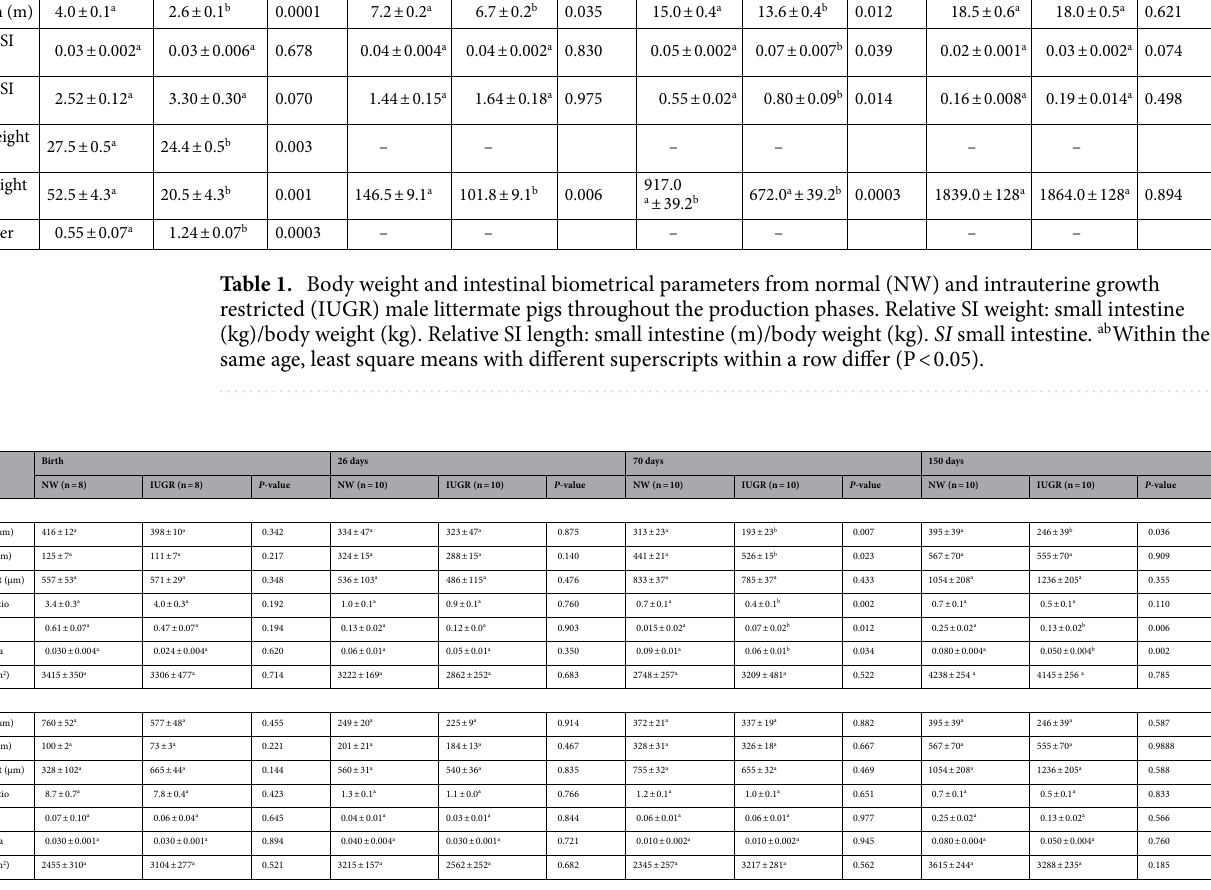
Table 2. Small intestine histomorphometrical parameters from normal (NW) and intrauterine growth restricted (IUGR) male littermate pigs throughout the production phases. Villus/crypt ratio: villus height/crypt depth. V.S.A villus surface area. G.C/crypt goblet cell number per crypt. ab Within the same age, least square means with different superscripts within a row differ (P < 0.05).